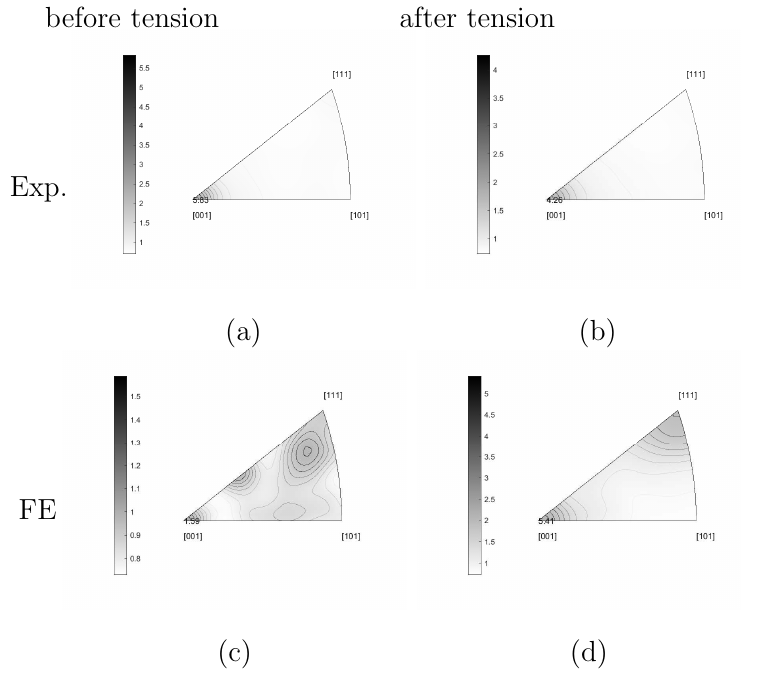
Fig. 11: Standard inverse pole figures for the AgSnO 2 PM12-3 composite: (a) EBSD measured initial Figure 11. Standard inverse pole figures for the AgSnO 2 PM12-3 composite: ( a ) EBSD measured texture after hot extrusion and before tension; (b) measured texture after tension; (c) initial texture initial texture after hot extrusion and before tension; ( b ) measured texture after tension; ( c ) initial texture for FE simulation (for experiment Figure 7a); ( d ) FE predicted textures after for FE simulation; (d) FE predicted textures after tension.